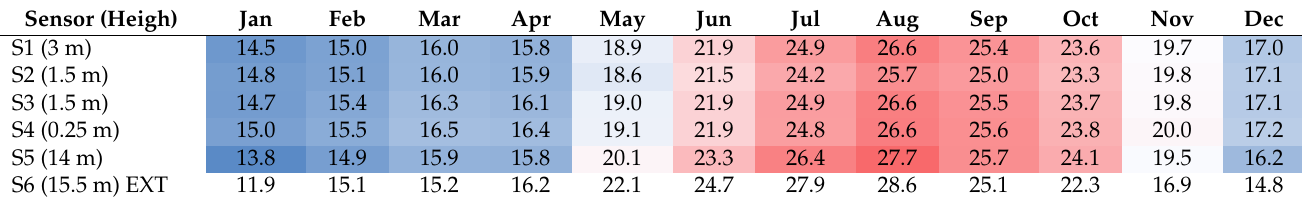
Table 6. Average temperature T ( ◦ C) registered by the sensors.